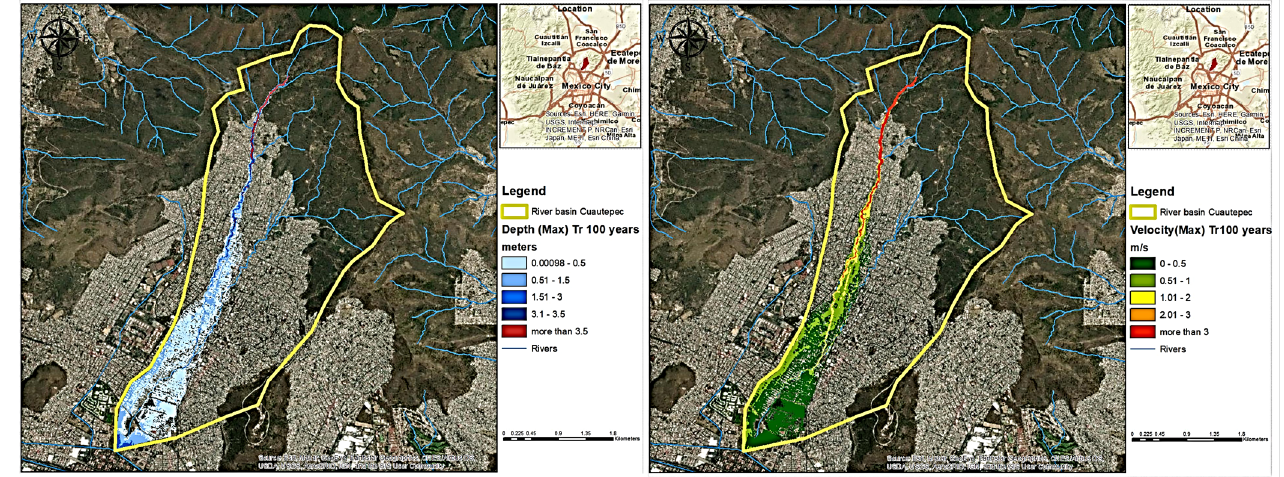
Figure 13. Maps of depths and maximum velocity for Tr 100 years using Hec ‐ Ras2d.